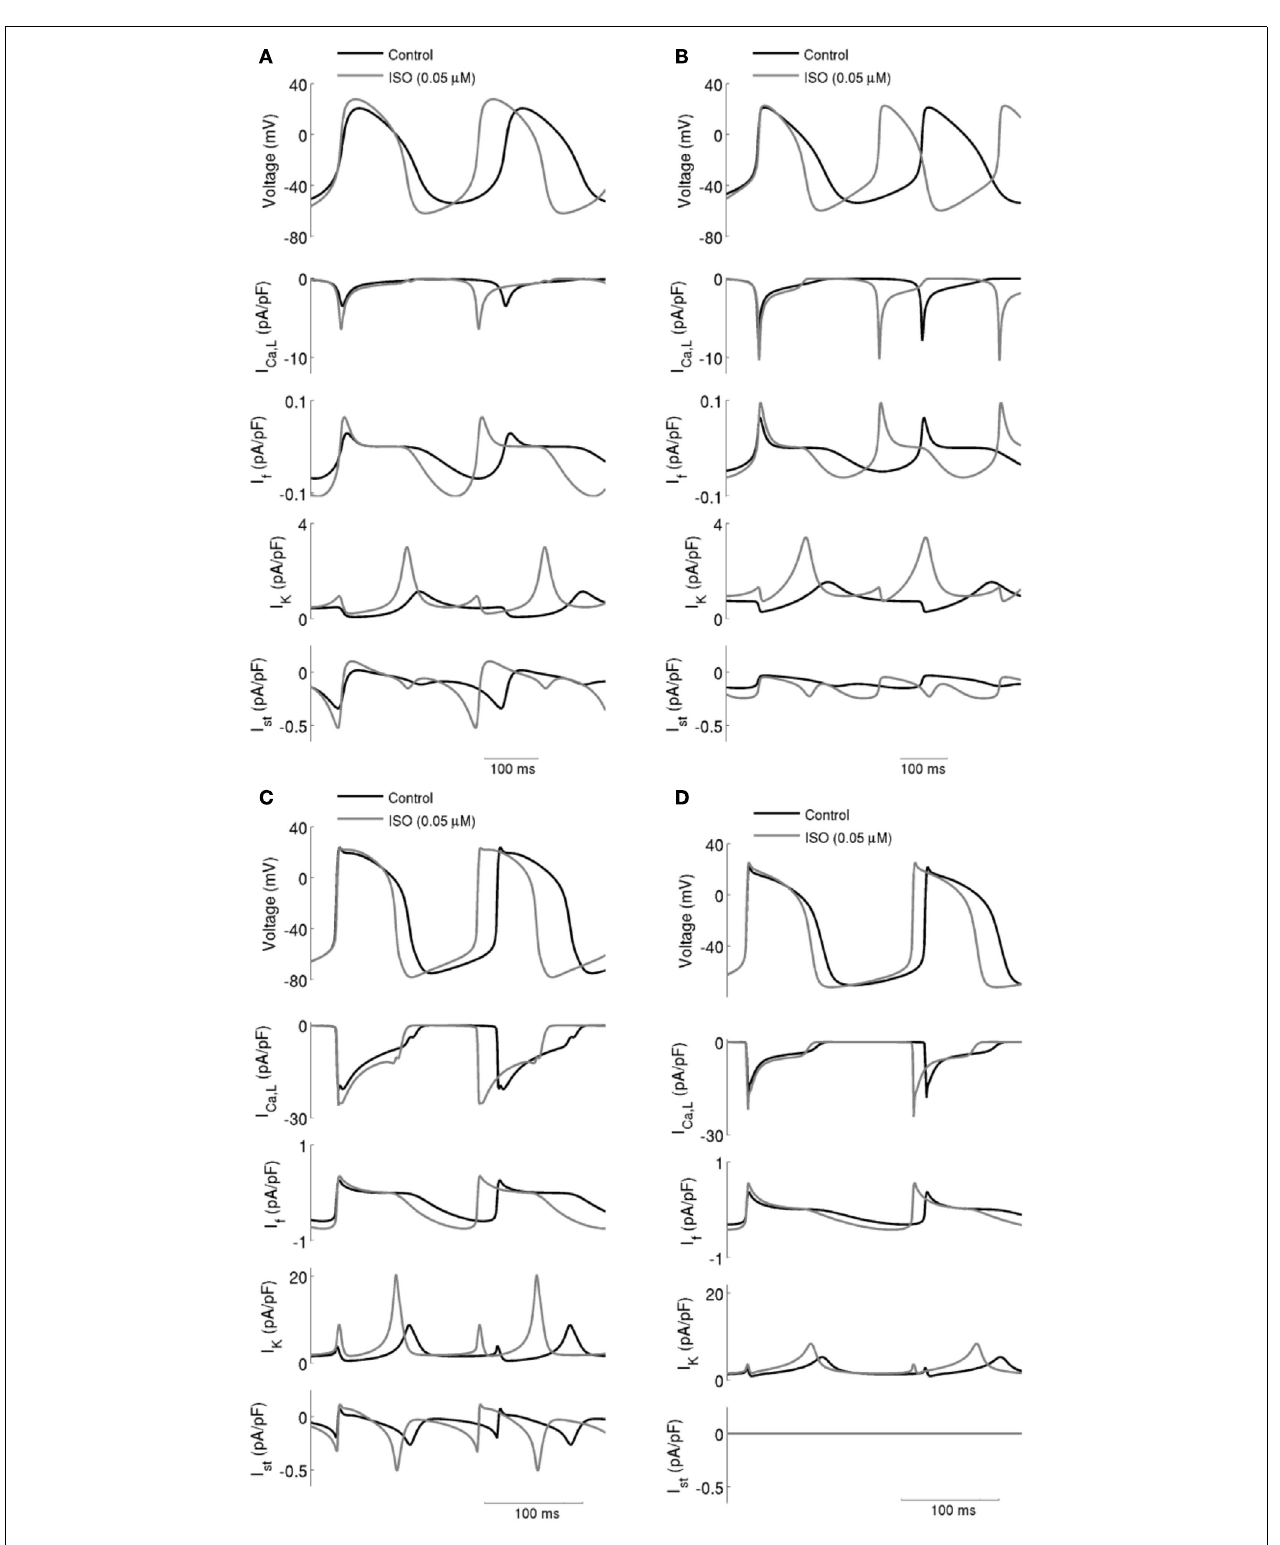
Kurata et al. peripheral cell models. In all four cell models, ISO caused an increase in spontaneous firing rate and this was accompanied by increases in I CaL , I f , I K , and I st